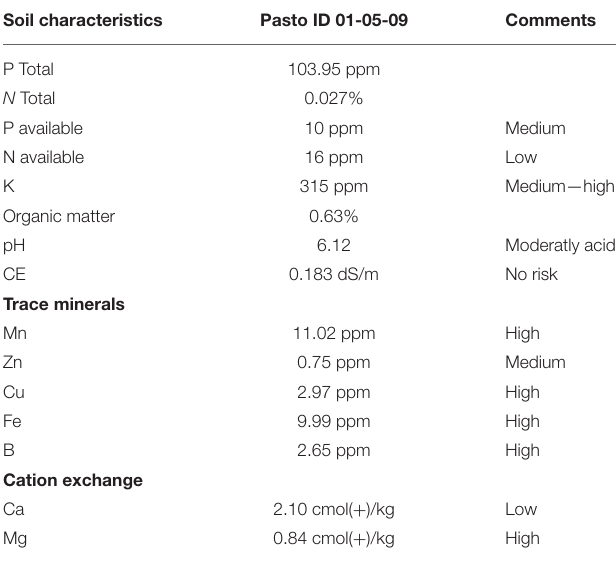
TABLE 1 | Soil characteristics from the isolate collection site in San Pedro de Atacama (as indicated by CTSyC laboratory). Soil